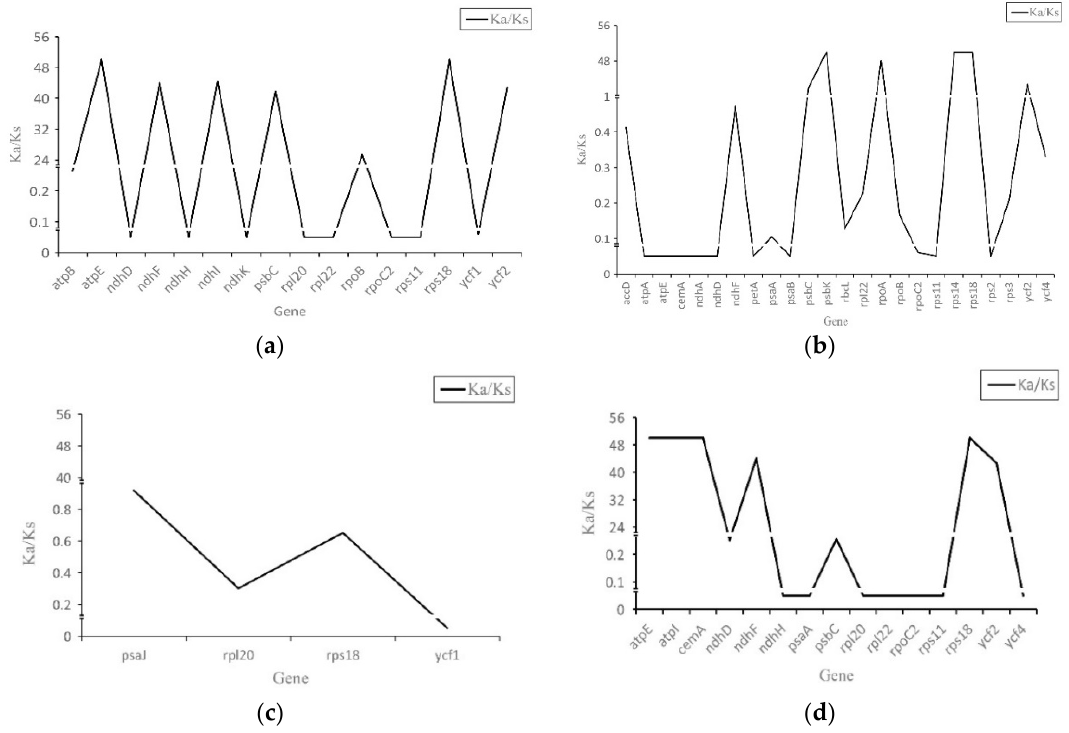
Figure 2. Ka/Ks value of five Pyrus species. ( a )‒( d ) represent the Ka/Ks values of Pyrus betulifolia , Pyrus Pyrus communis L. cv. Early Red Comice, Pyrus ussuriensis Maxin. cv. Jingbaili, and Pyrus communis L .cv.Early Red Comice, Pyrus ussuriensis Maxin .cv. Jingbaili, and Pyrus hopeiensis HB-2, respectively, with respect to Pyrus hopeiensis HB-1.